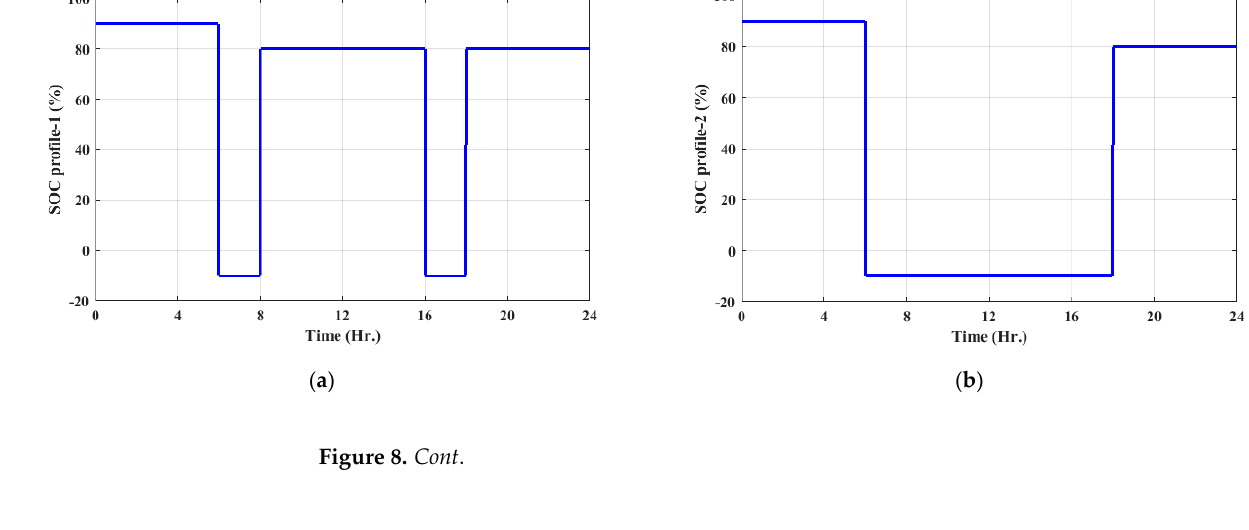
Figure 7. Load profile.